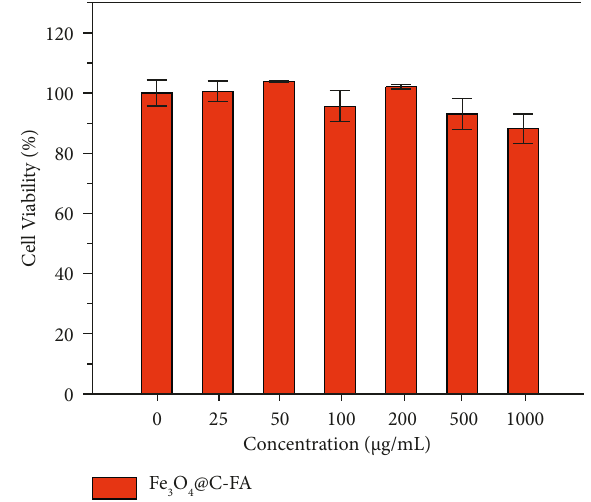
Figure 5: The MTTassay of HeLa cells cell viable after incubations of different concentrations (0, 25, 50, 100, 200, 500, and 1000 μ g/ mL) of Fe 3 O 4 @C-FA at 37 ° C for 48 h. Error bars indicate the mean ± standard deviations ( n �